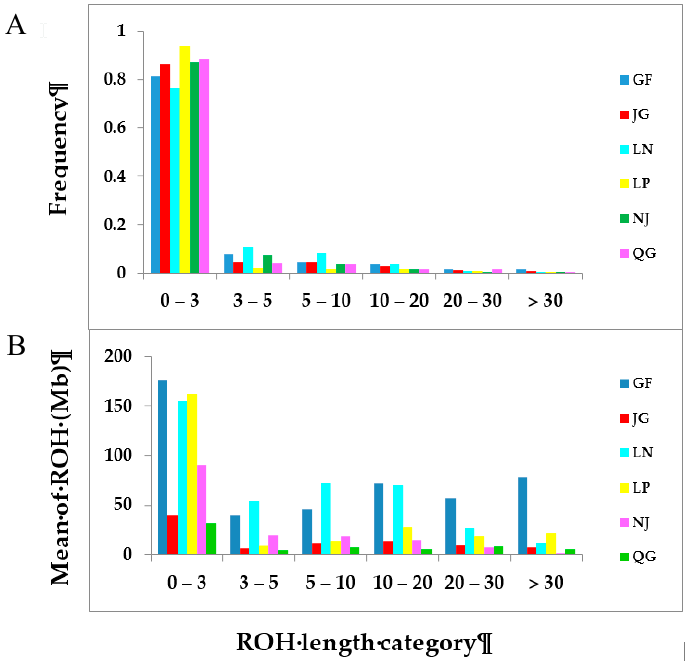
Figure 4. ( A ) Frequency of ROHs in different length categories in six goat populations. ( B ) The average sum of runs of homozygosity (ROH) of each breed in different ROH length classes.